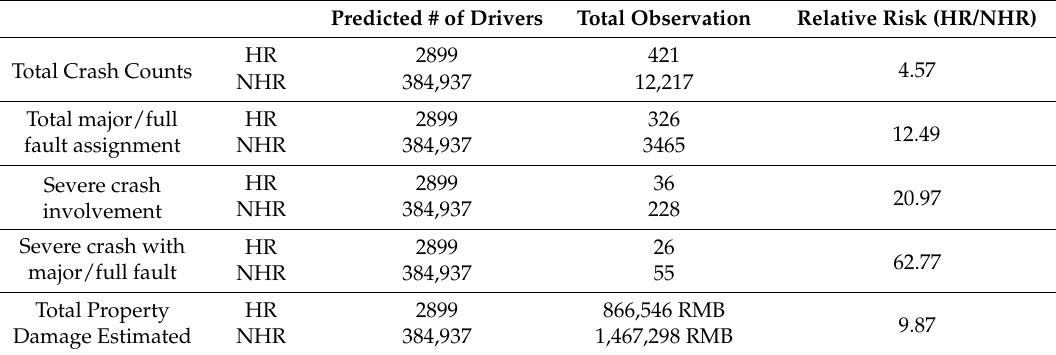
Table 4. Relative risk of predicted CP over NCP between 2018.1 and